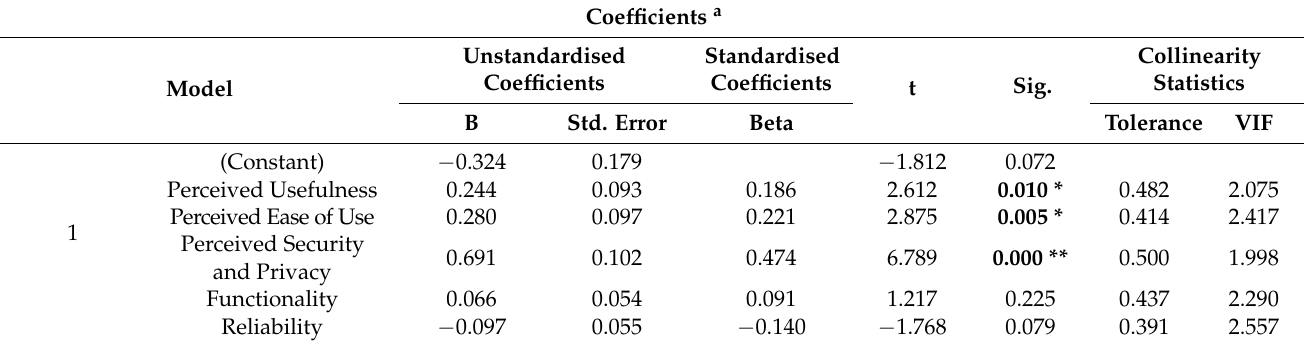
Table 14. Regression analysis on the intention to use WIoMT